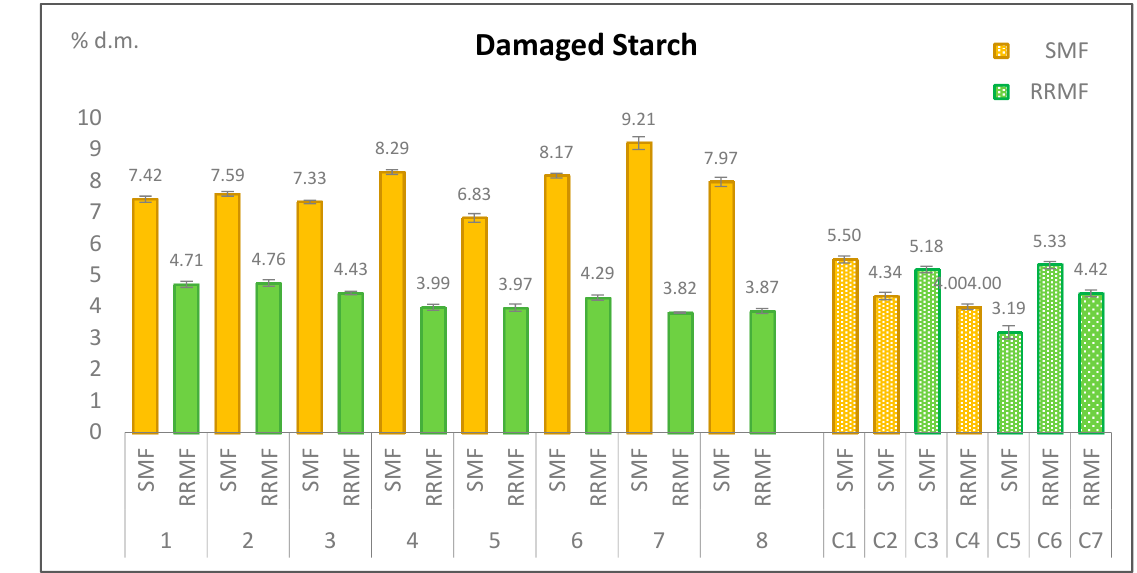
Figure 2. Damaged starch content in wholegrain stone milled, recombined roller milled and commercial soft wheat flours. Table 1. Phytic acid in milling products obtained by means of stone and roller milling (and reference flour) from eight soft wheat